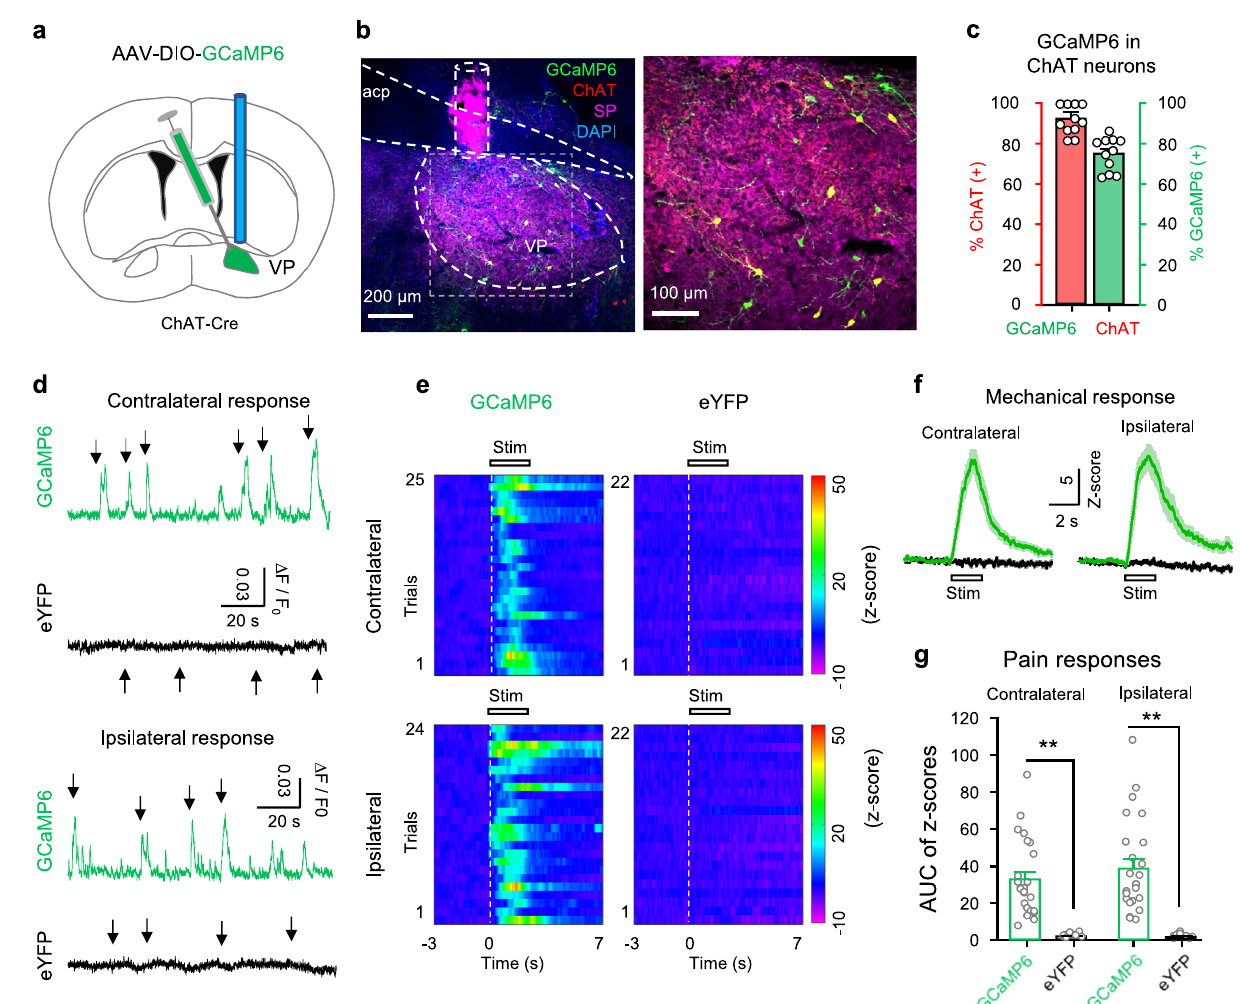
Fig.2|EnhancedactivityinVPChATneuronsuponacutepain-likestimulation. a AAV-EF1 α -DIO-GCaMP6s was injected into the VP of ChAT-Cre mice. b A repre- sentativeimageofacoronalsectioncontainingGCaMP6(green)-labeledneuronsand ChAT- and SP-antibody-stained neurons and tissue. c Ef fi ciency (green) (74±3.20%, n =12 section from six mice) and speci fi city (red) (93±2.4%, n =12 sections from six mice) of GCaMP6-labeling of ChAT neurons in the VP ( n =5 mice). d Representative raw traces showing the responses of GCaMP6-labeled (green) and eYFP-labeled (black)ChATneuronsintheVPtopain-likestimulation(pressure)onthecontralateral and ipsilateral hind paws. Arrow, pain-like stimulation. e Heat maps showing the